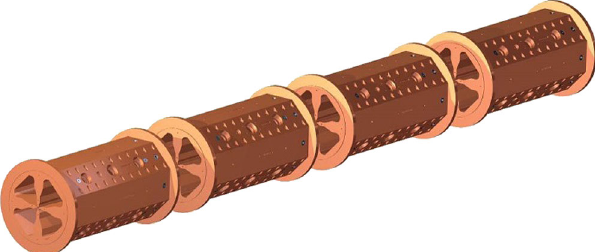
FIG. 1. Detailed 3D engineering model of the RFQ made of four segments.